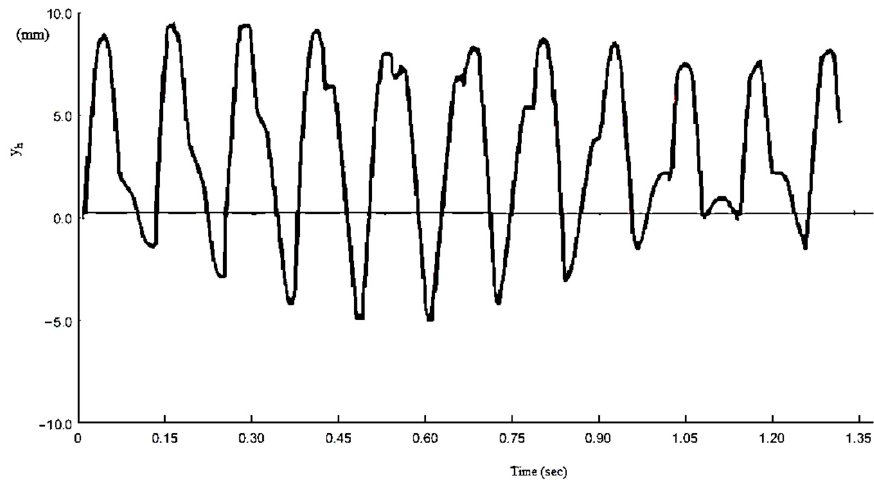
Figure 12. The recoil displacement curve, showing change in the Gatling gun vs. time.